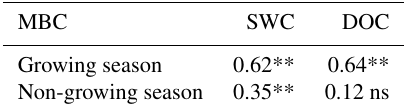
Table 2. Pearson correlations of MBC between SWC and DOC dur- ing growing and nongrowing